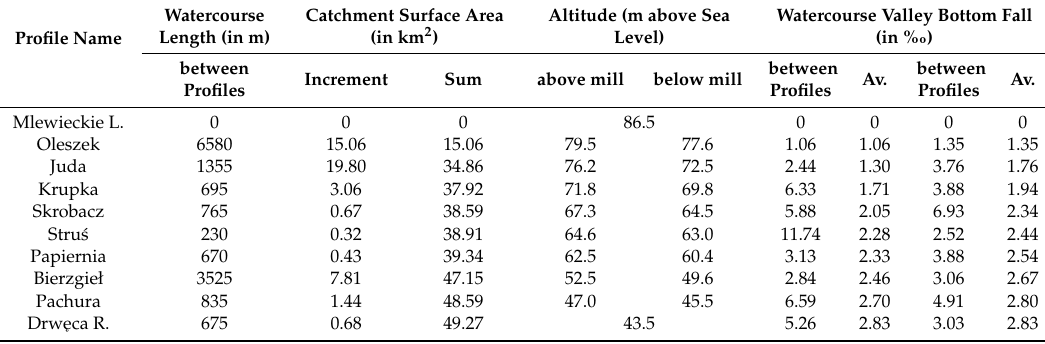
Table 2. The Struga Rychnowska catchment increases according to measurements of a topographic map (1:10,000)